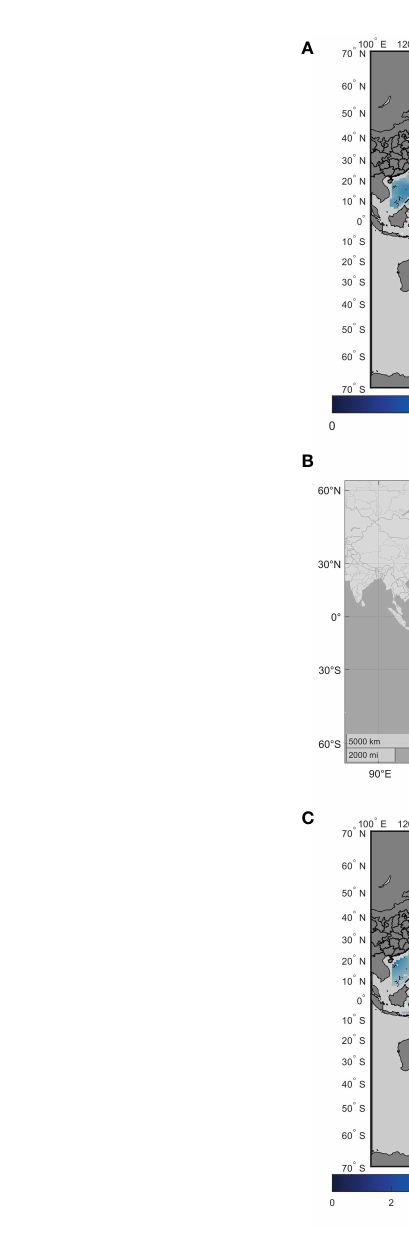
FIGURE 6 Long-term average distribution of (A) surface POC concentration during 2002-2020 (Stramski et al., 2008), (B) POC fl ux at 30-600m during 1988-2019 (the POC fl ux data were collected from references listed in supplement), and (C) change of anthropogenic CO 2 in the Paci fi c at 200-600m during 1994-2007 (Gruber et al.,